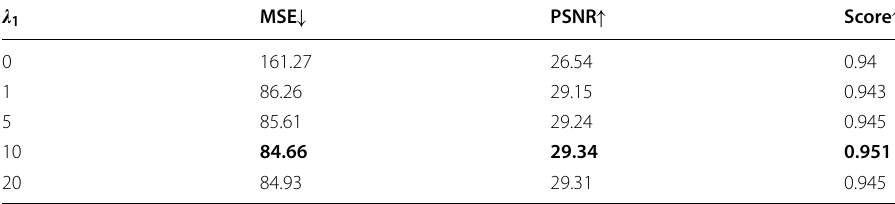
Bold values indicate the best results Table 5 Result comparison on SHU dataset with different values of the key parameter (cid:31) 2 (cid:31)